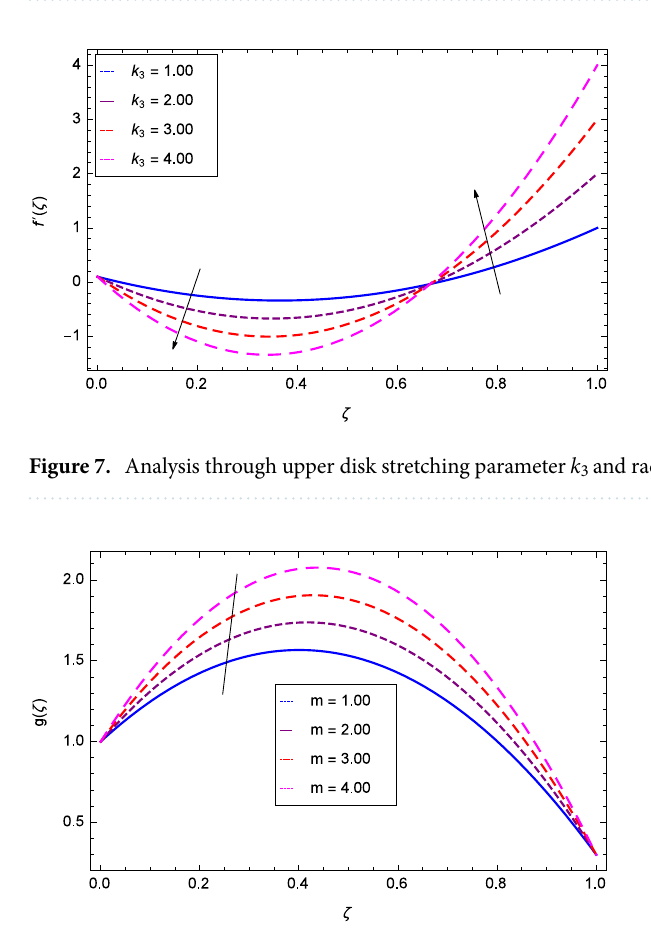
Figure 6. Analysis through lower disk stretching parameter k 2 and radial velocity f ′ ( ζ ).